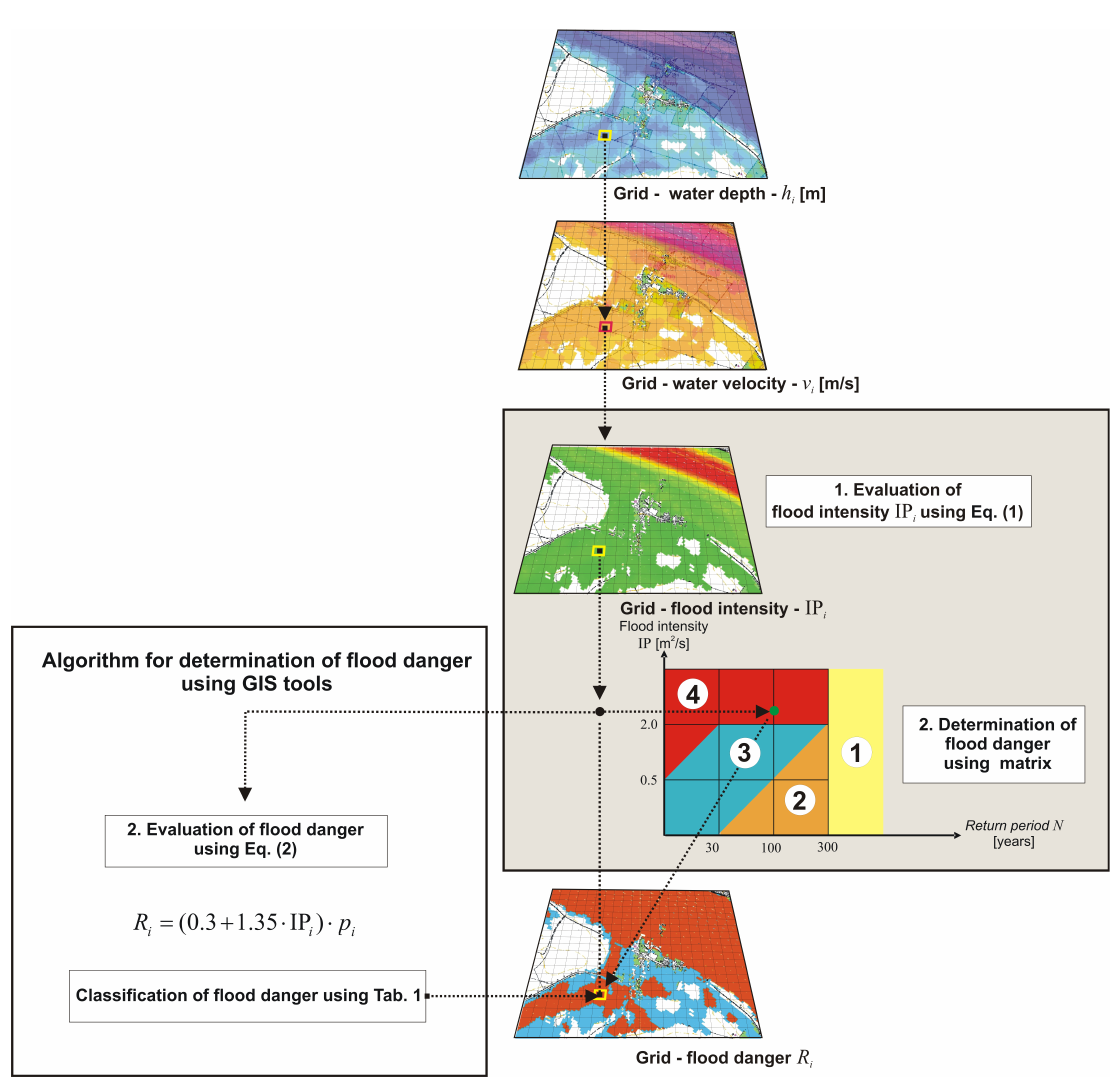
Fig. 2. Flow chart for the development of flood hazard and flood danger maps for a given flood scenario (peak discharge).